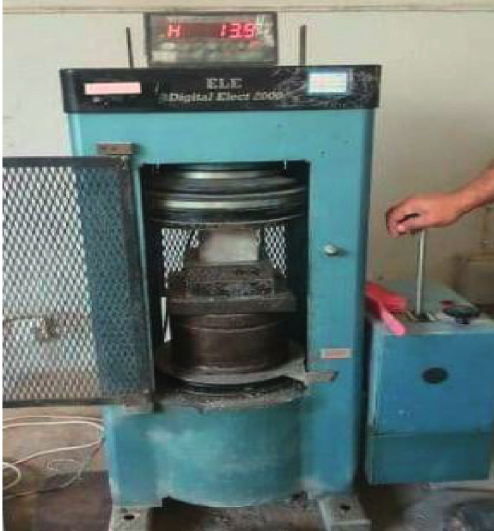
Figure 4: Compressive strength test.